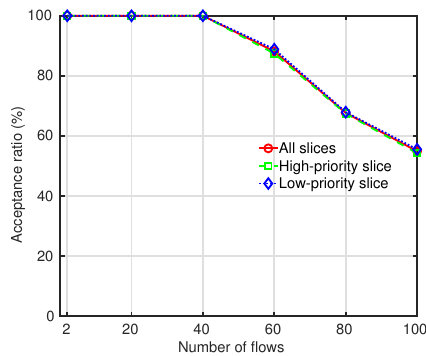
Figure 6. Acceptance ratio with respect to different numbers of